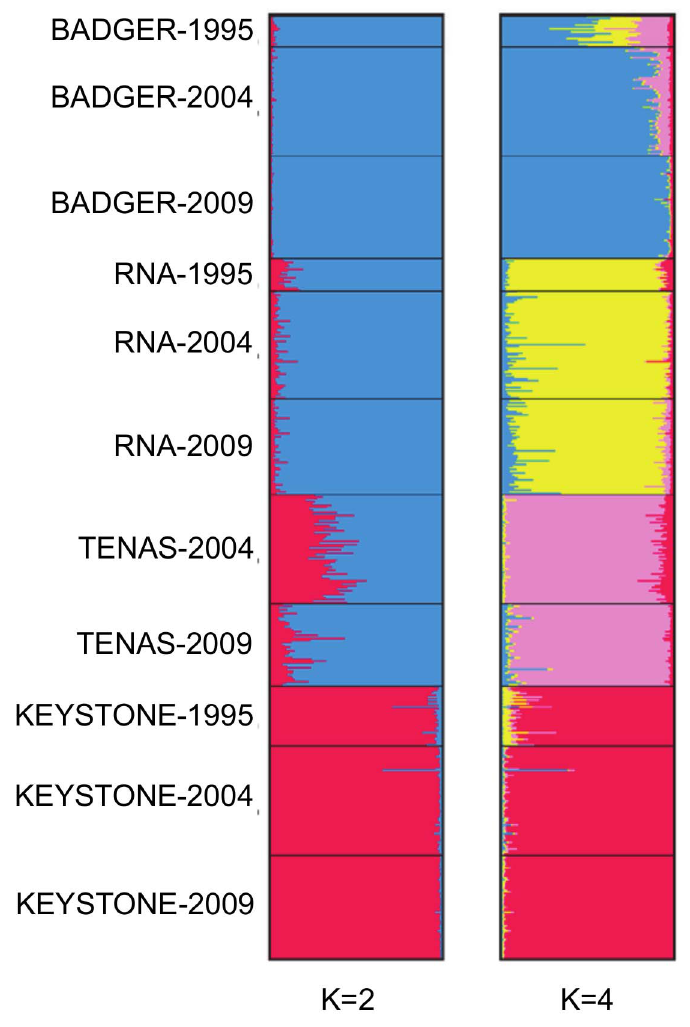
Figure 3. Q-plots based on AFLP analyses. Bayesian analysis using the software STRUCTURE suggested most likely groups of K=2 and K=4.